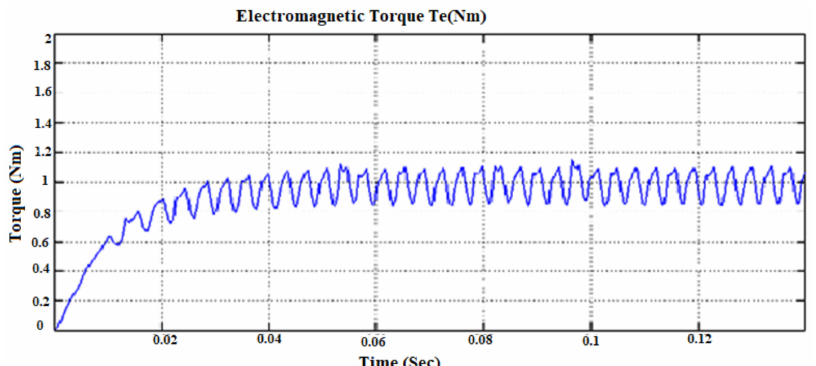
Figure 20. Torque ripple waveform with 3 ◦ magnetic